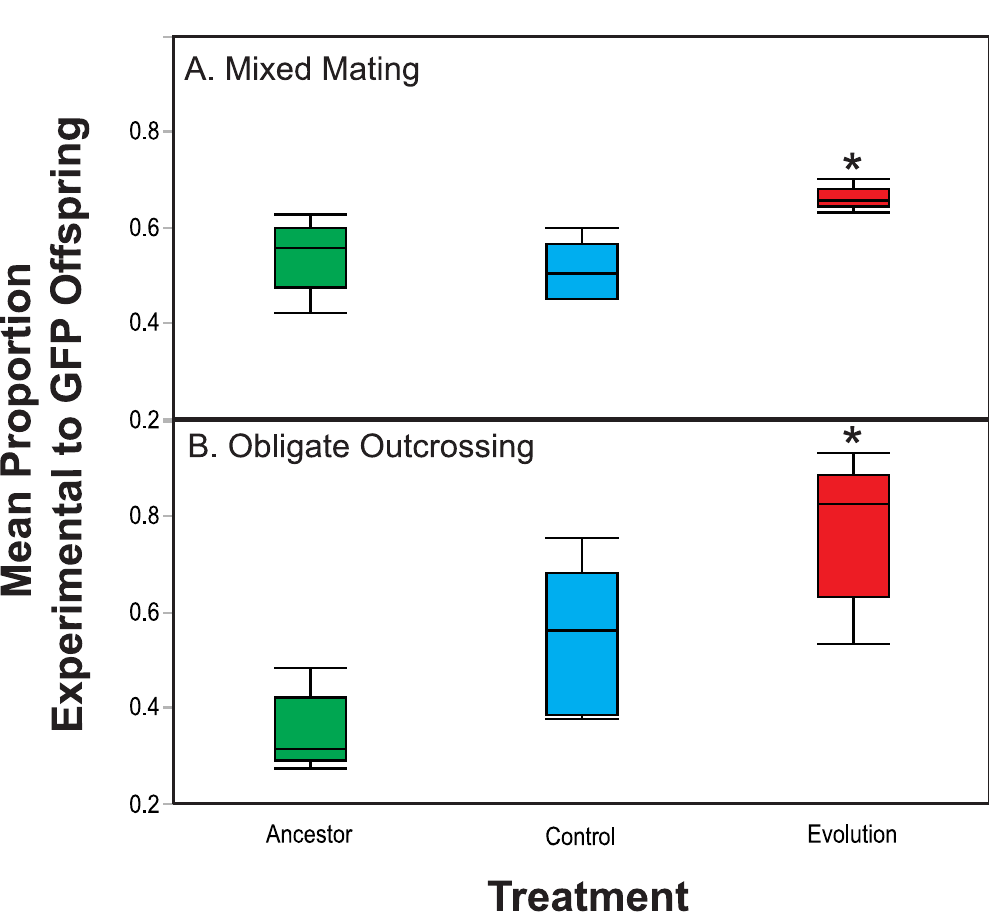
Fig 1. Competitive fitness during exposure to S . marcescens . Populationsexposed to the Control and Evolution treatments, as well their Ancestral populations,were competedagainsta tester strain in the presence of S . marcescens . Experimental and tester strain individuals were exposedto the parasite, starting at a 1:1 ratio, for one generation. Greater mean proportions of experimental individuals indicategreater competitive fitness. (A) Mixed mating populationsexposedto the Evolutiontreatment exhibitgreater competitive fitness than the Ancestral or Controlpopulations.(B) Obligatelyoutcrossingpopulations exposedto the Evolution treatment exhibit greater competitive fitness than their respectiveAncestral and Control